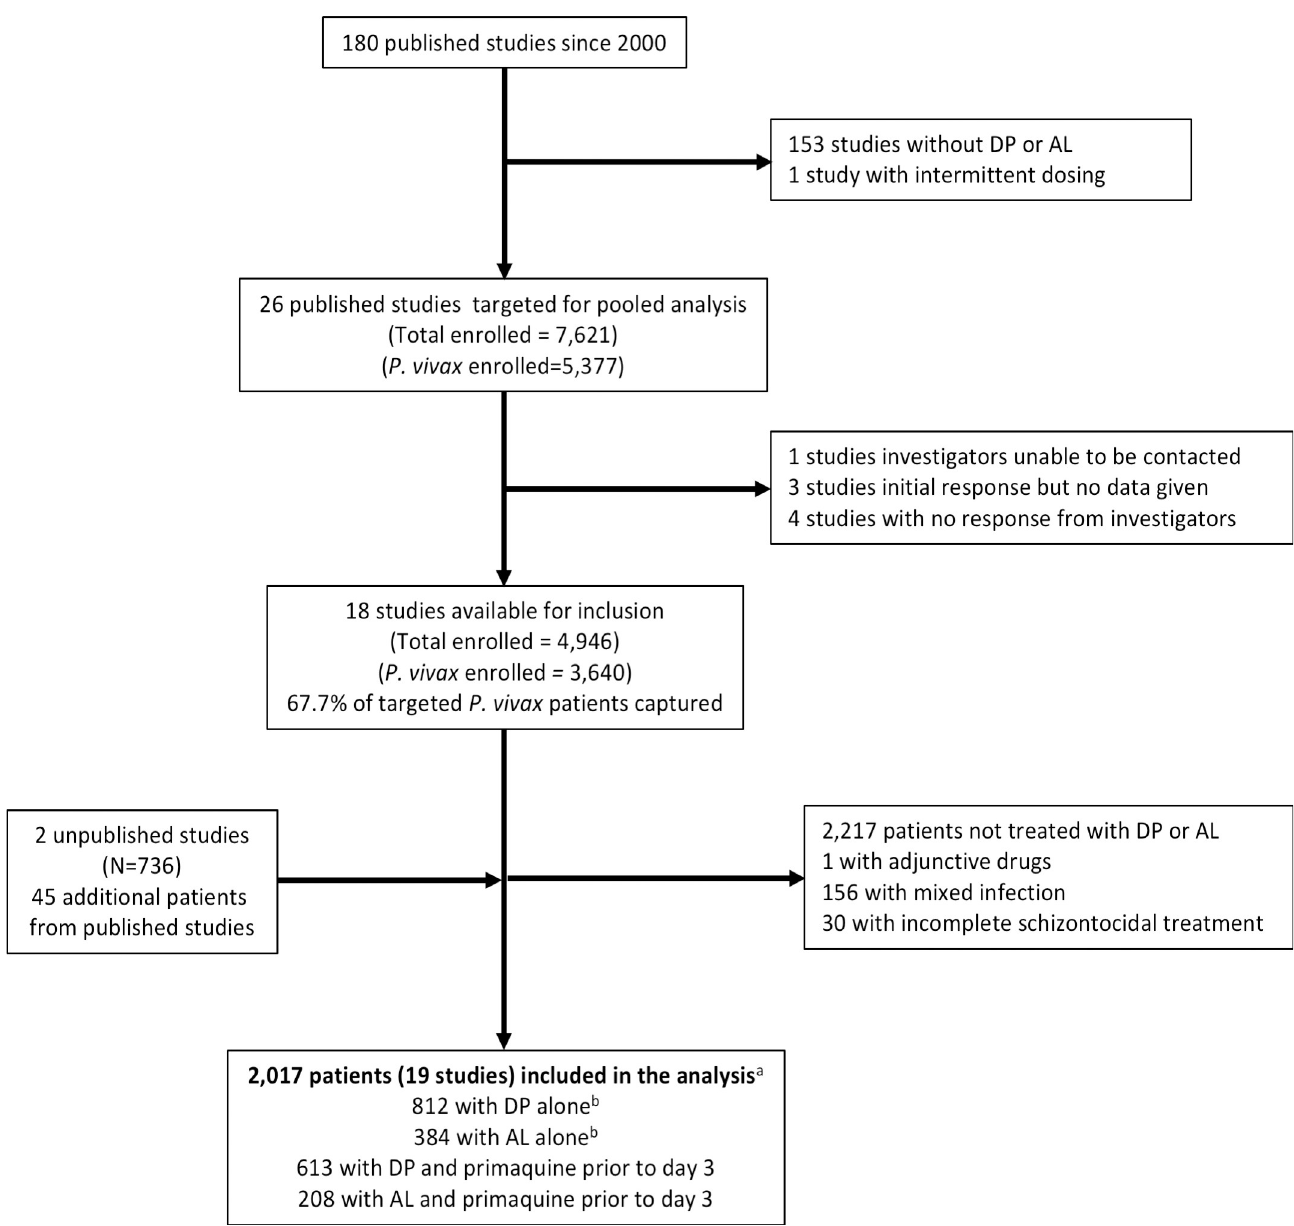
Fig 1. Study flowchart. a One study was excluded entirely because patients treated with AL or DP all had mixed infections [43]. b Includes 100 patients treated with DP and two patients treated with AL who received primaquine at day 28 and were censored at this day. AL, artemether-lumefantrine; DP, dihydroartemisinin-